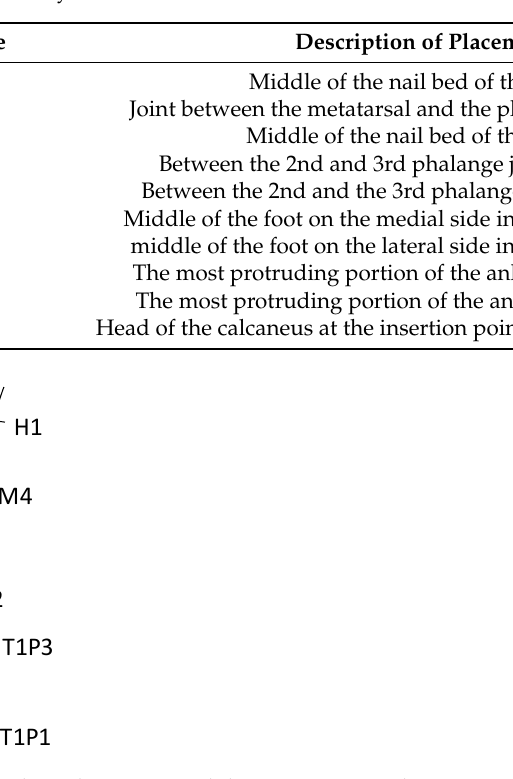
Table 1. Naming convention and anatomical description for the 10 marker locations (m) where vibration transmissibility was measured.